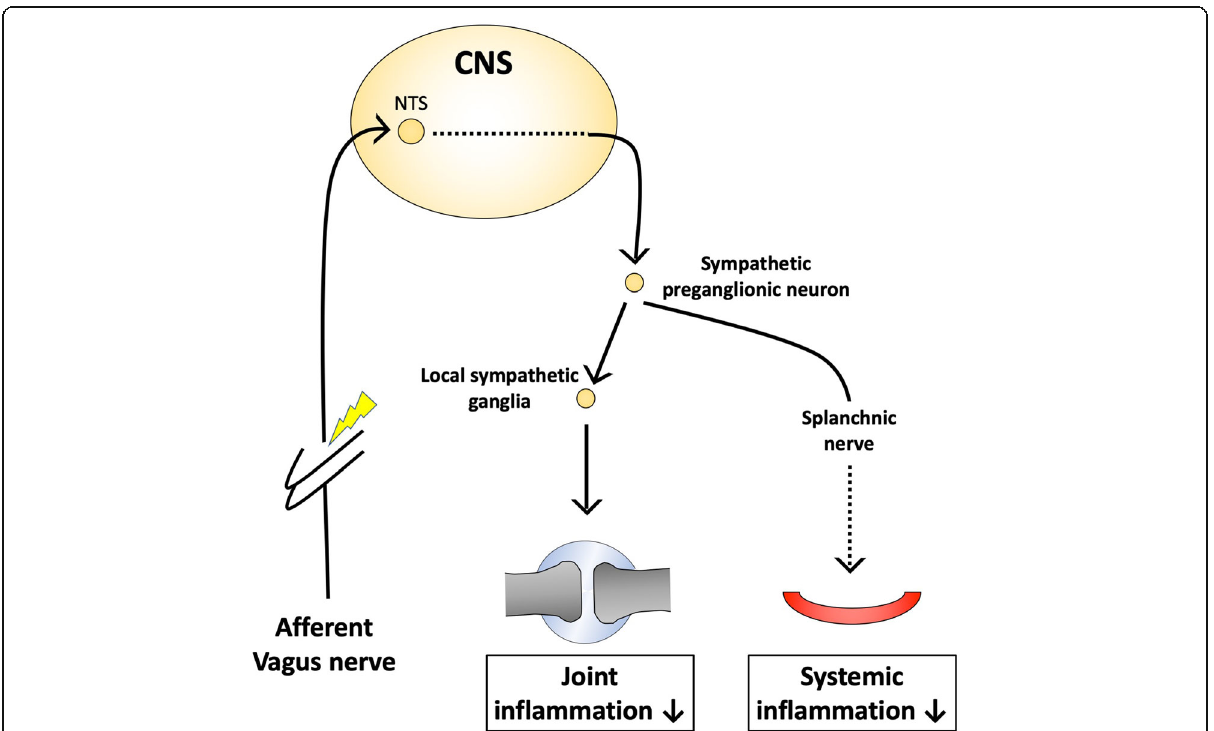
Fig. 2 Another anti-inflammatory pathway elicited by afferent vagus nerve stimulation. Afferent vagus nerve stimulation can elicit an anti- inflammatory pathway involving sympathetic efferents through the central nervous system (CNS). In a model of joint inflammation, the local release of norepinephrine from sympathetic nerve terminals within joints alleviates inflammation. On the other hand, the splanchnic sympathetic nerve seems to be important to suppress systemic inflammation after lipopolysaccharide administration. Direct target(s) of the splanchnic nerve is not clear. NTS, nucleus tractus